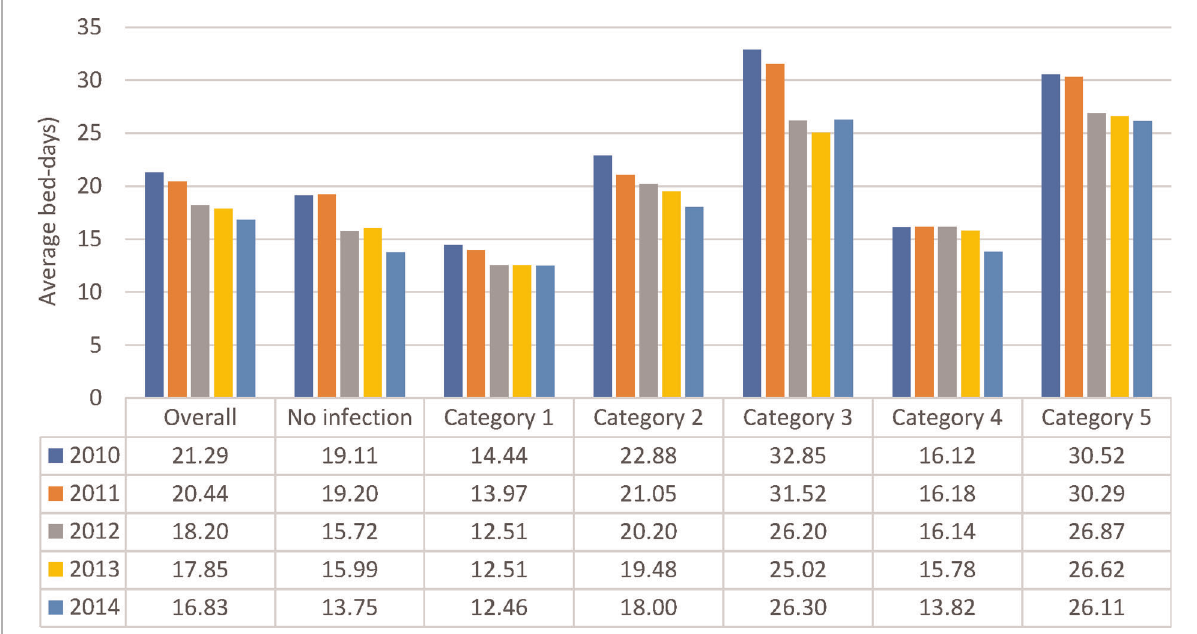
FIGURE 6 Average hospital bed-days by infection category over the years of observation for the geriatric ward.